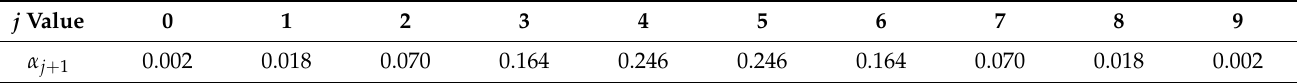
Table 4. Weight value α j + 1 of a j